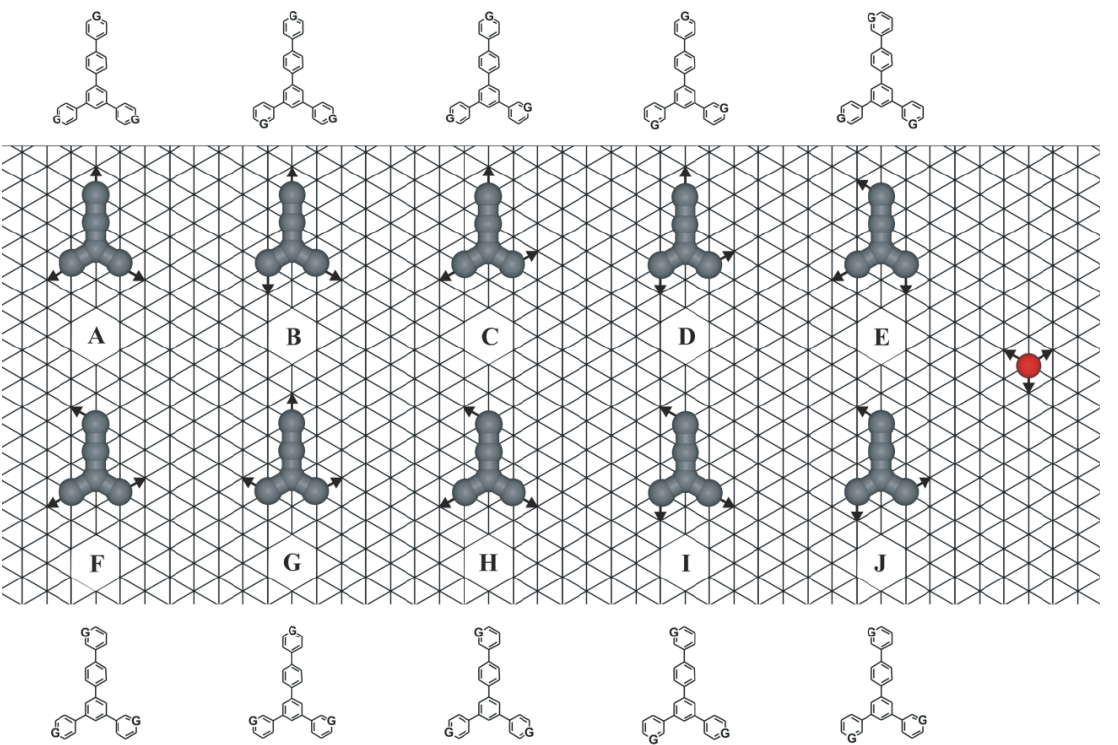
Figure 1. A survey of Y-shaped positional isomers A – J and their modeled counterparts adsorbed on a triangular lattice. The black arrows attached to the terminal segments of the simulated molecules denote the positions of active centers (functional groups of real organic molecules: G = ni- trile/propiolonitrile moiety, ring-nitrogen atom), able to interact reversibly with the coadsorbed trivalent metal atom (red, isolated segment). For clarity, in the case of prochiral units ( B – F and H – J ) only one surface isomer, denoted arbitrary as ( S ), is shown. The vertices of a triangular lattice represent isolated adsorption sites present in an energetically homogenous metallic surface with (111) geometry.